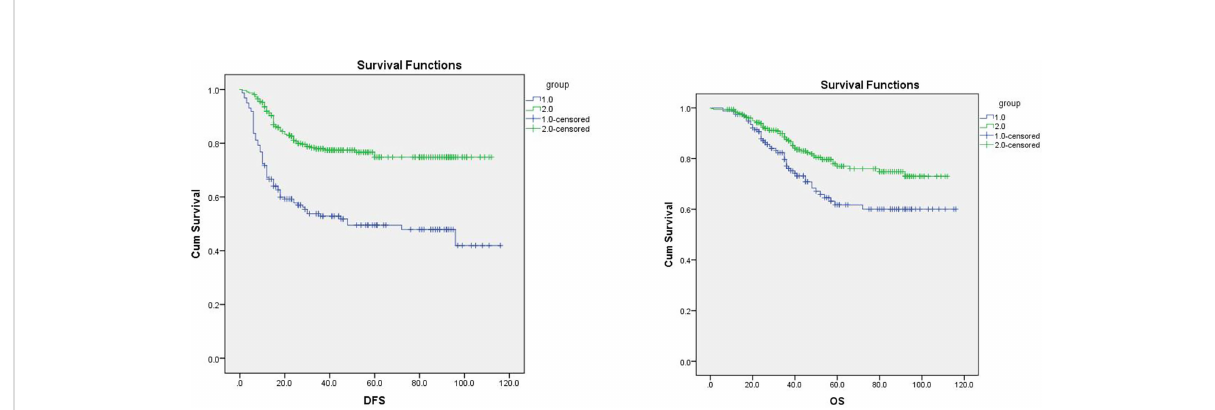
FIGURE 1 Overall survival (OS) and PFS of the two groups. Note: Group 1 is the infection group, and group 2 is the non-infection group. The longest follow-up was 120 months, in which changes in disease-free survival (DFS) and overall survival (OS) were signi fi cant (P <